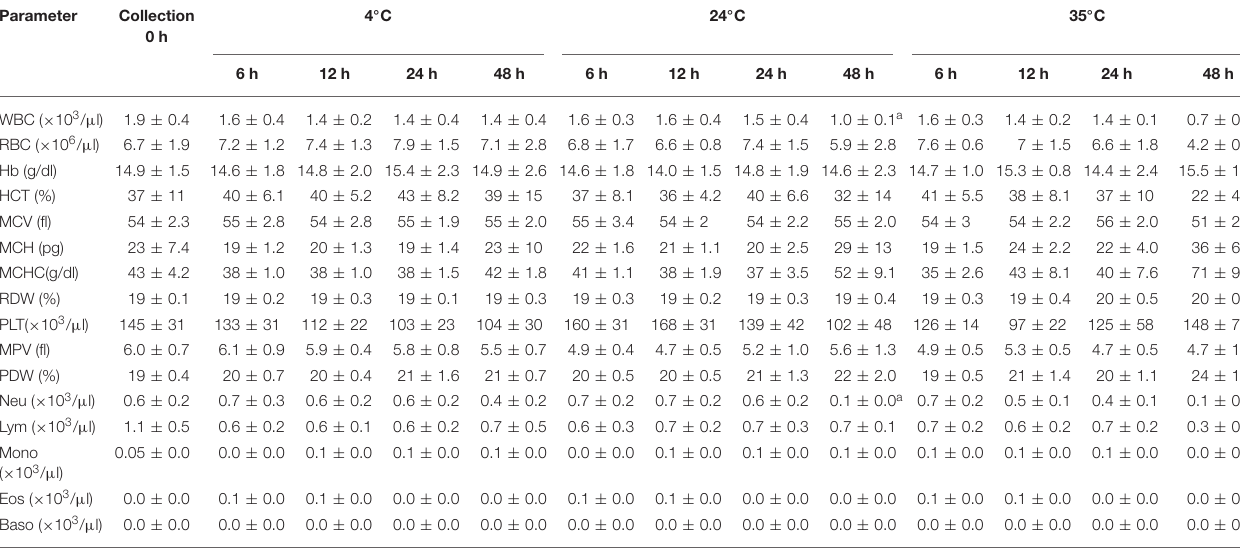
Results are expressed as mean ± SD. WBC, white blood cell count; RBC, red blood cell count; Hb, hemoglobin concentration; HCT, hematocrit; MCV, mean corpuscular volume; MCH, mean corpuscular hemoglobin; MCHC, mean corpuscular hemoglobin concentration; RDW, red cell distribution width; PLT, platelet count; MPV, mean platelet volume; PDW,